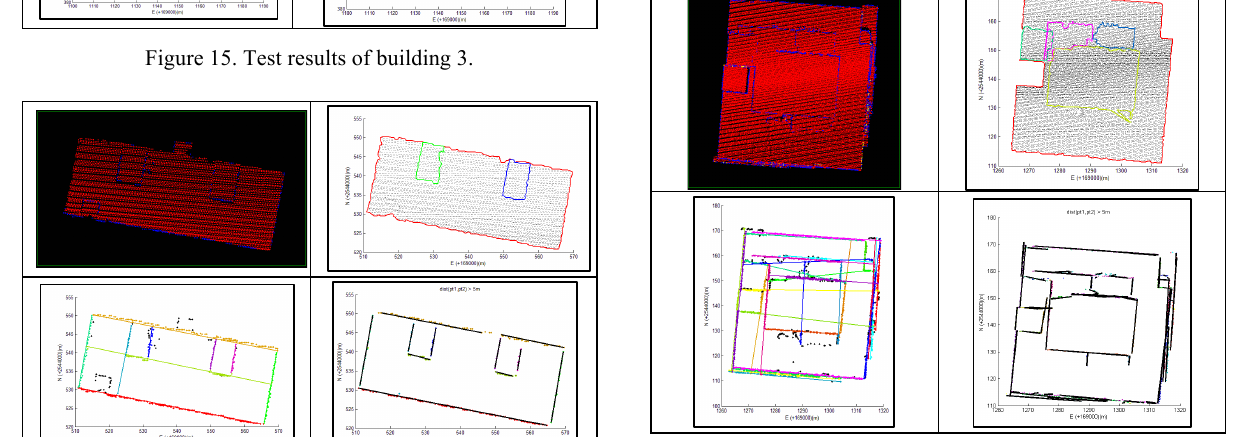
Figure 19. Test results of building